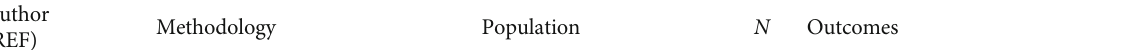
Table 1: Summary of clinical evidence regarding SGLT2i in cardiovascular, renal, and anthropometric